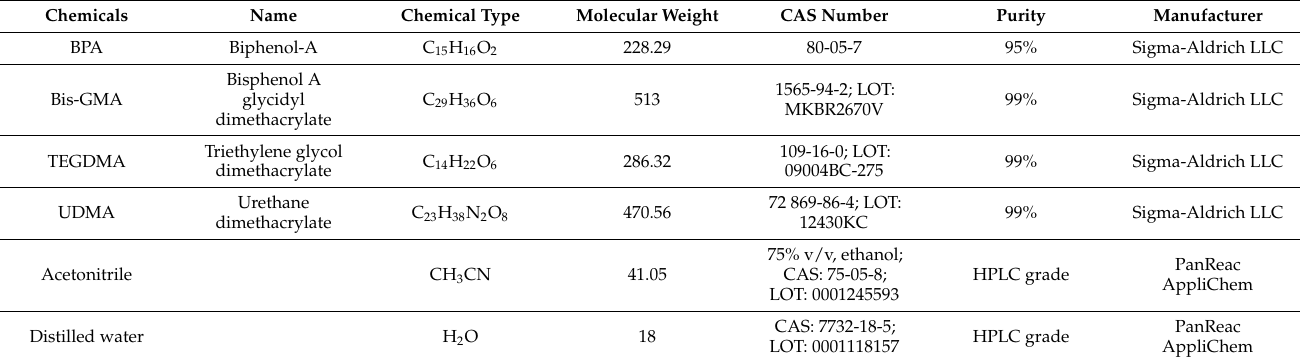
Table 2. Substances, chemical type, molecular weight, CAS number, and